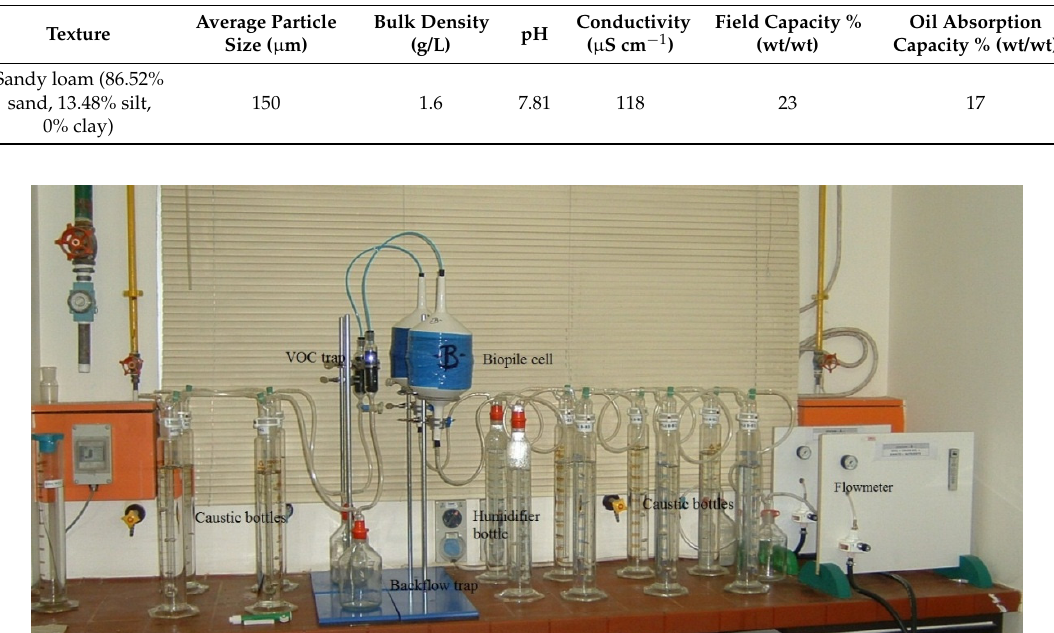
Table A1. Sahel oil field clean soil properties.